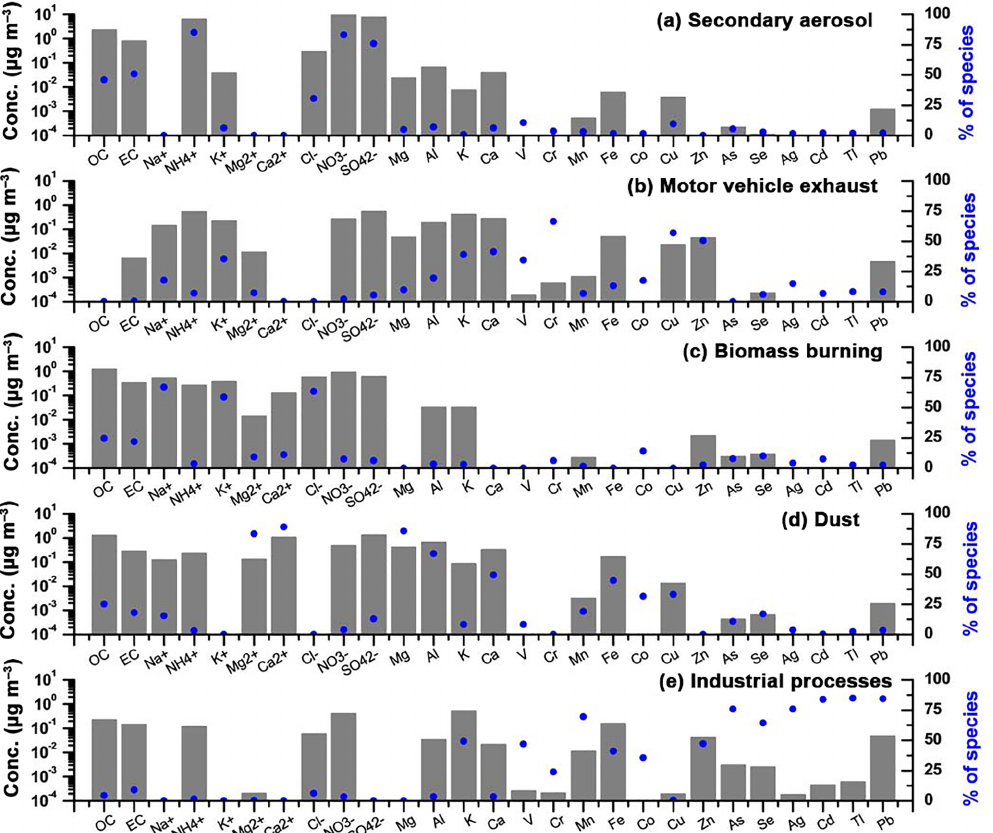
Figure 5. PMF source factor profiles for the PM 2 . 5 samples throughout the entire study period in Xinglong in terms of concentrations (µgm − 3 ) and percentages